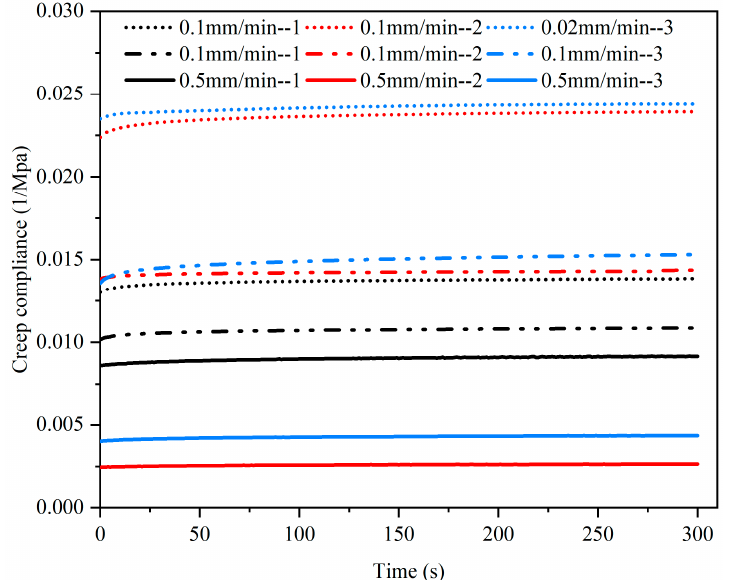
Figure 11. Creep compliance–time curves of three samples at different rates.